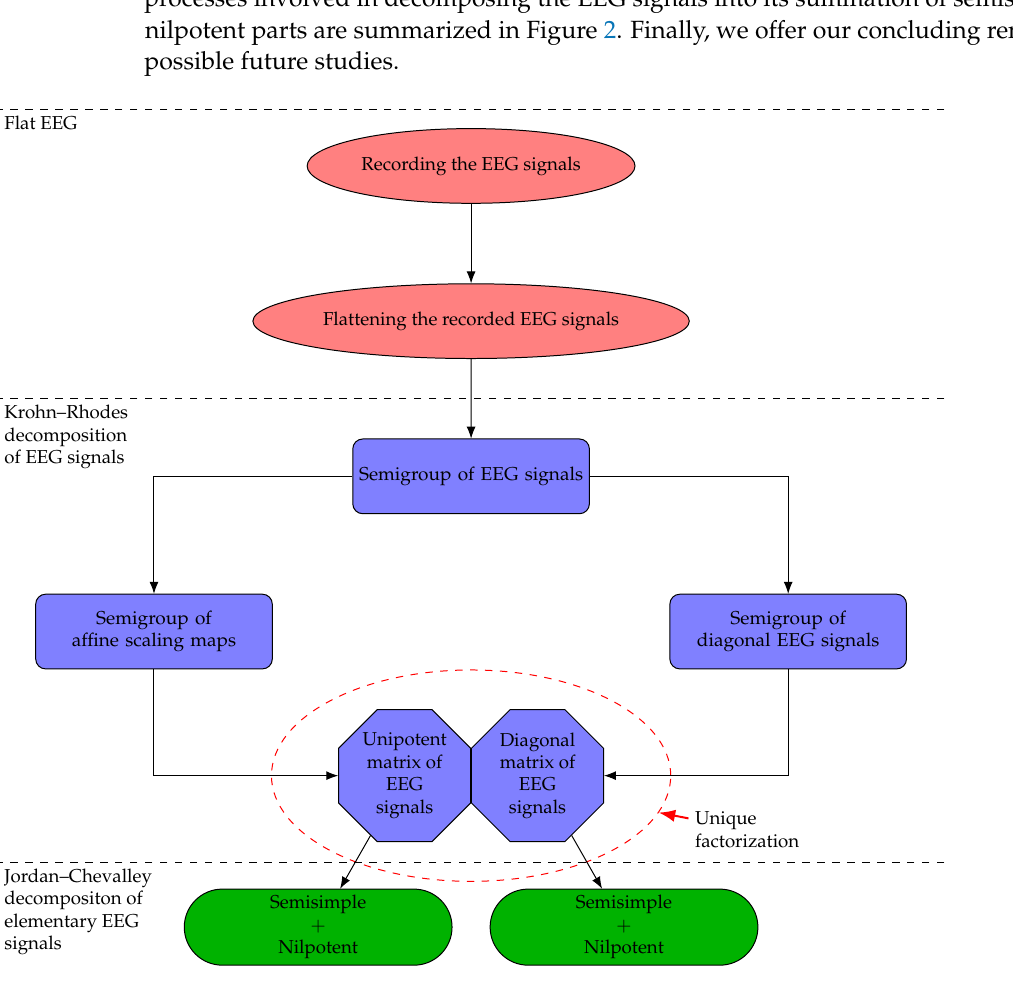
Figure 2. The procedure of decomposing the EEG signals into its summation of semisimple and nilpotent